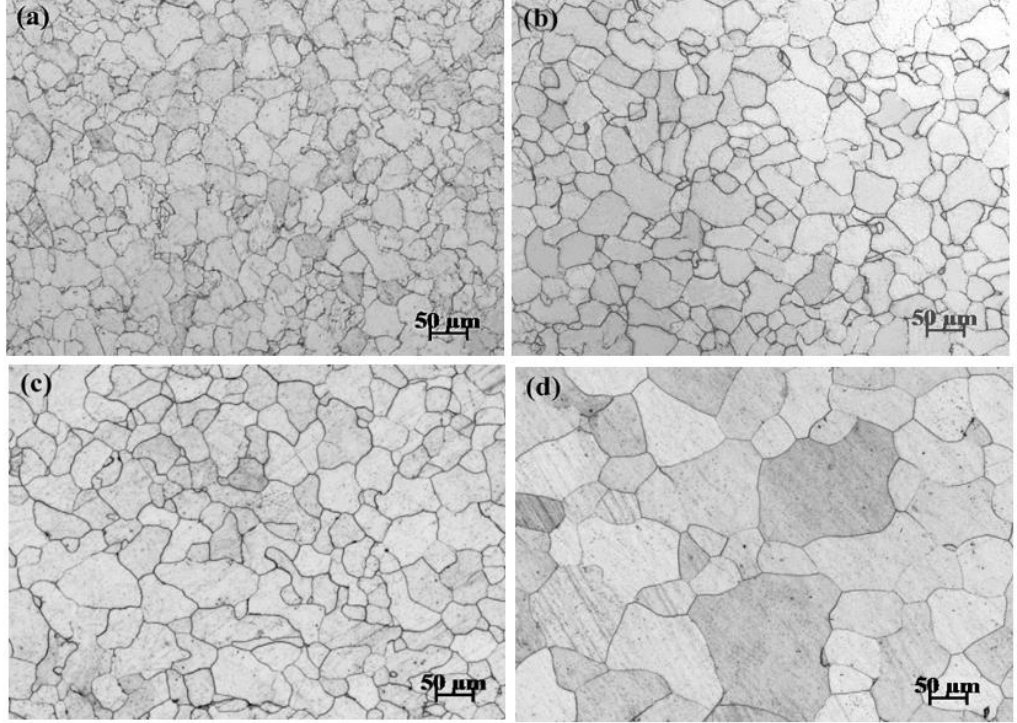
Figure 2. Optical micrographs at ( a ) the initial forged condition and ( b – d ) the different annealed conditions: ( b ) 765 °C, ( c ) 785 °C, ( d ) 805 °C.